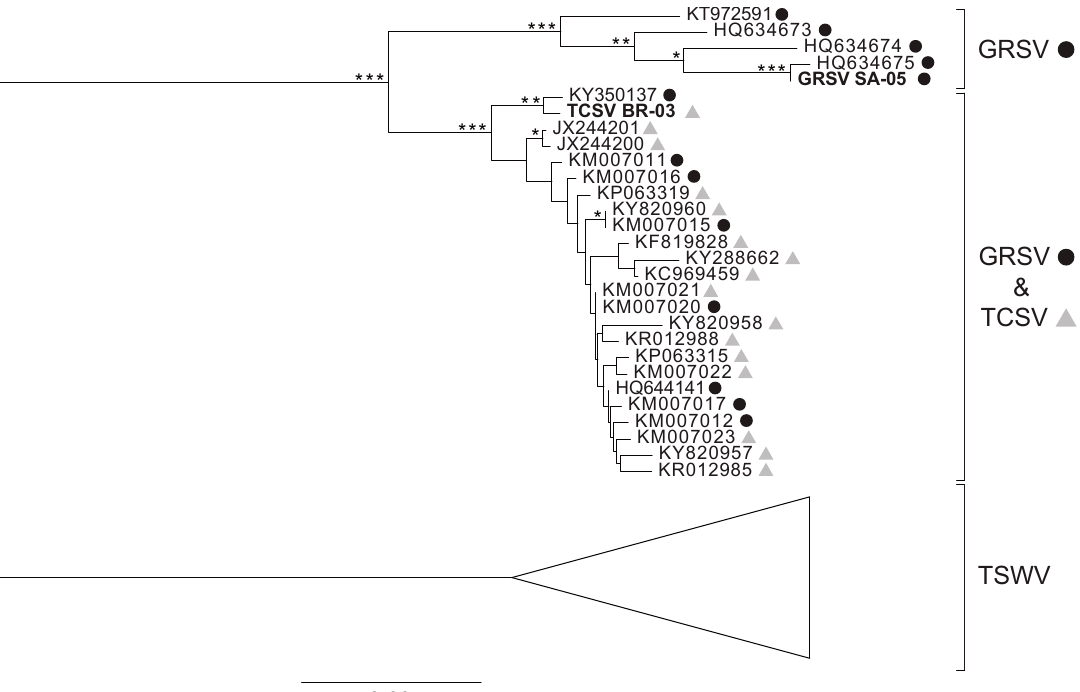
Figure 1. Phylogenetic tree based on NSm gene fragments from groundnut ringspot virus (GRSV), tomato chlorotic spot virus (TCSV), and tomato spotted wilt virus (TSWV) isolates. TCSV sequences are represented by grey triangles next to their accession numbers, while GRSV sequences are represented by black circles. Nodes with bootstrap values above 50%, 70%, and 90% are indicated by one, two, and three asterisks, respectively.